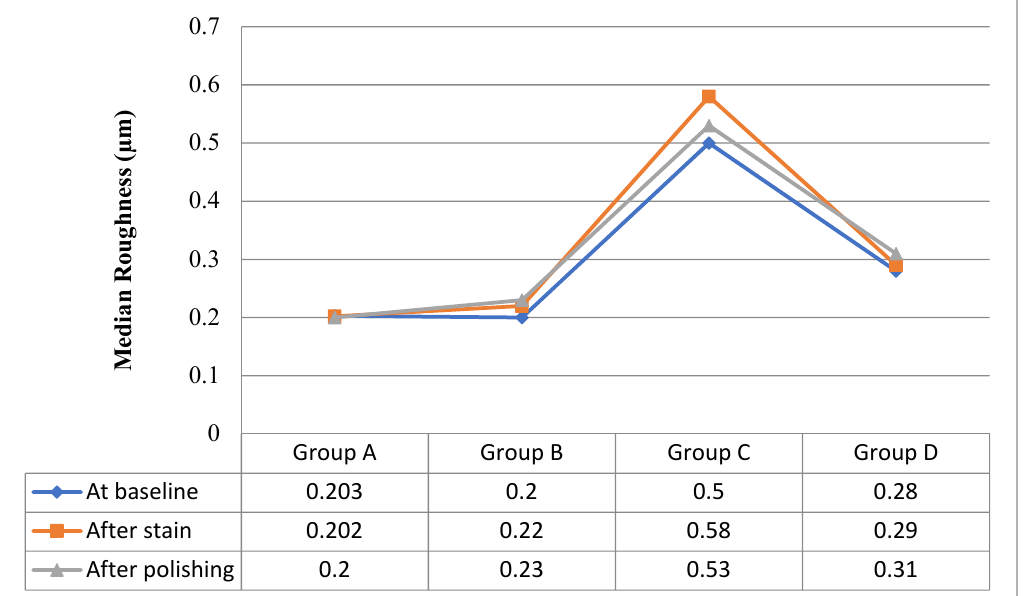
Figure 2. Median composite resin roughnesses at baseline, after staining, and after